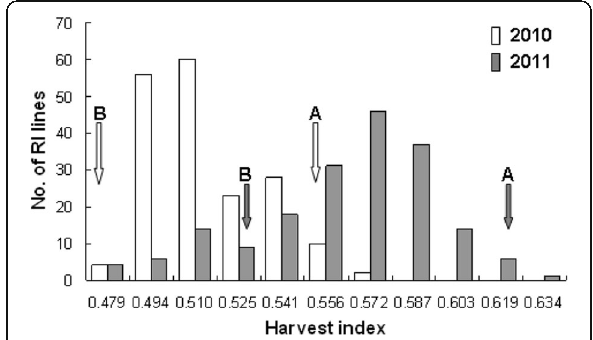
Fig. 1 Distribution of harvest index in RIL population derived from YXZ and SBSM in two years (2010 and 2011). A and B indicate the harvest index of YXZ and SBSM,